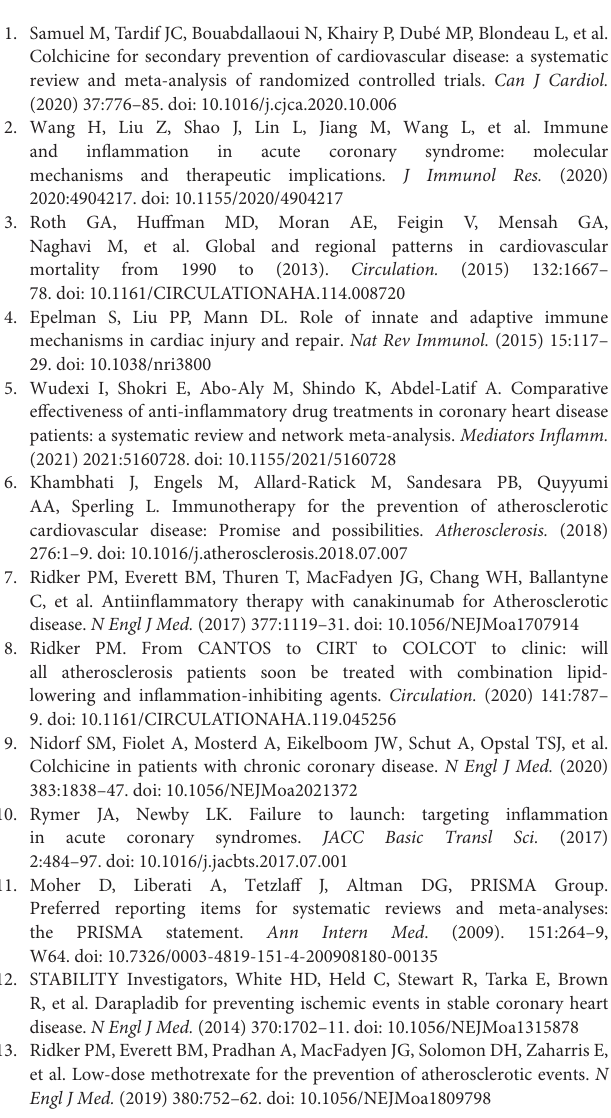
Supplementary Figure 3 | Forest plots of studies evaluating all-cause mortality in patients receiving anti-inflammatory agents vs. placebo. Supplementary Figure 4 | Forest plots of studies evaluating cardiac mortality in patients receiving anti-inflammatory agents vs. placebo. Supplementary Figure 5 | Forest plots of studies evaluating recurrent myocardial infarction in patients receiving anti-inflammatory agents vs. placebo. Supplementary Figure 6 | Forest plots of studies evaluating stroke in patients receiving anti-inflammatory agents vs. placebo. Supplementary Figure 7 | Forest plots of studies evaluating revascularization in patients receiving anti-inflammatory agents vs. placebo. Supplementary Figure 8 | Funnel plots of odds ratios and standard errors to assess the publication bias of anti-inflammatory agents vs. placebo in primary end points (A), secondary end points (B), all-cause mortality (C), cardiac mortality (D), recurrent myocardial infarction (E), stroke (F) and revascularization (G).